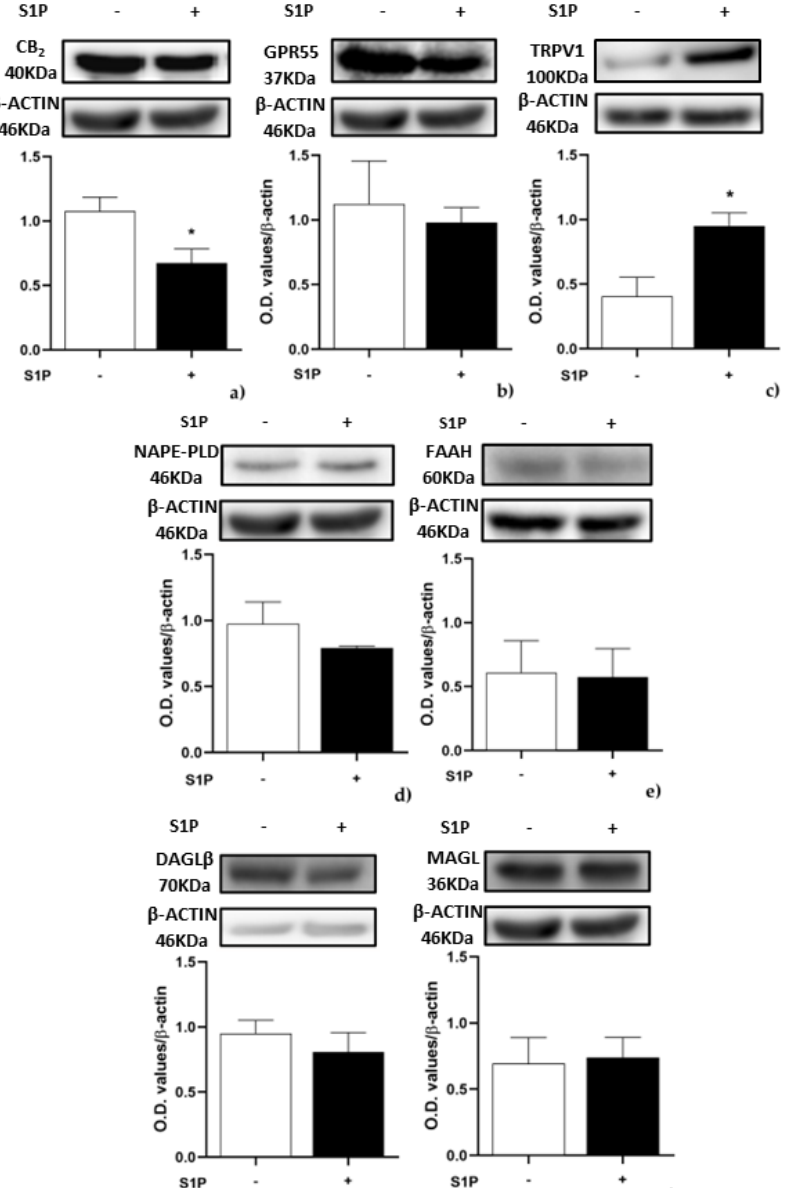
Figure 3. Effect of S1P on protein expression of endocannabinoid (eCB)-binding receptors and metabolic enzymes: C2C12 cells were left untreated (in white) or were treated for 24 h with 1 µ M S1P (in black). Samples were subjected to Western blotting analysis using specific antibodies against the following proteins: ( a ) CB 2 ; ( b ) GPR55; ( c ) TRPV1; ( d ) NAPE-PLD; ( e ) FAAH; ( f ) DAGL β ; ( g ) MAGL. Densitometric analysis values are expressed as relative optical density and normalized to β -Actin. The values represent the mean ± SEM of three independent experiments ( n = 3).